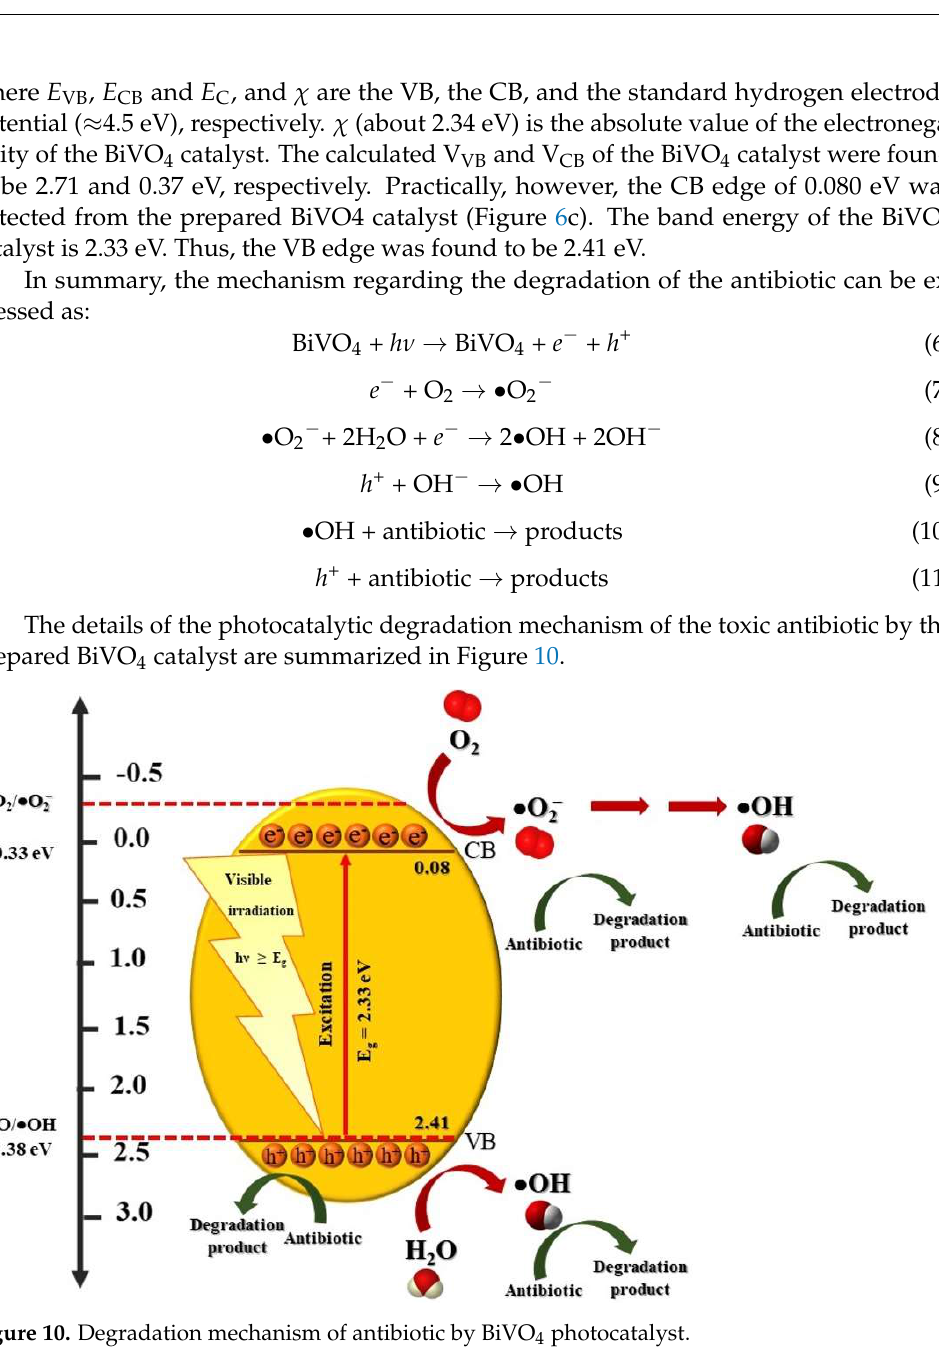
Figure 10. Degradation mechanism of antibiotic by BiVO 4